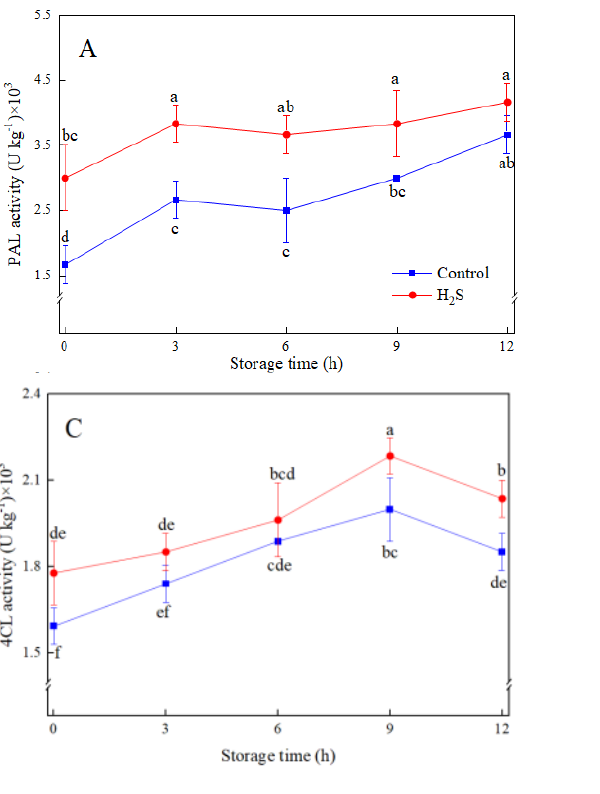
Figure 2. Effects of H 2 S treatment on the activities of PAL ( A ), 4CL ( B ), C4H ( C ), and PPO ( D ) of fresh-cut peaches during storage. Data are presented as mean ± standard errors of triplicate samples. Different letters indicate statistically significant ( p < 0.05) differences.